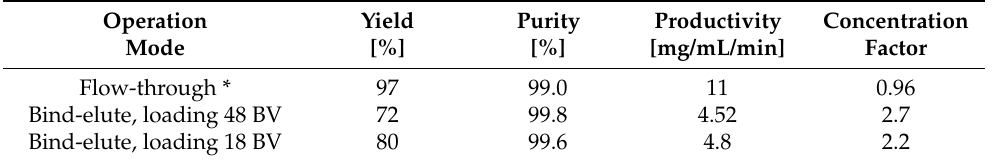
Figure 12. Two-component adsorption of BSA ( ● ) and DNA ( △ ) on Sartobind STIC from a feed containing 0.15 mol/L of Na 2 SO 4 using the laboratory membrane module in flow-through mode. Symbols represent the relative concentrations of BSA and DNA in the collected fractions. The solid black line is the relative outlet stream absorbance which is a superposition of BSA and DNA outlet concentrations. Red line indicates the moment of 10% breakthrough of DNA. Table 2. Performance indicators for BSA purification on Sartobind STIC using the laboratory mem- brane module in the negative flow-through mode and bind-and-elute mode,